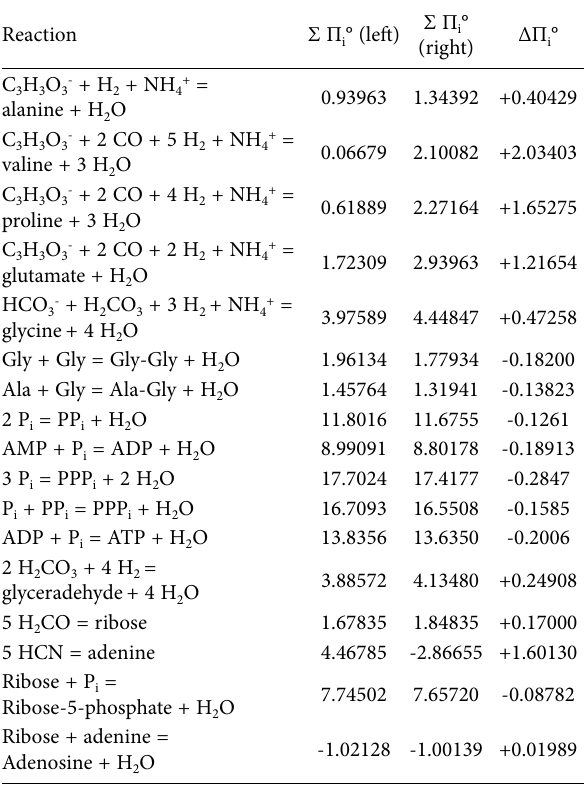
Table 9. Thermodynamic analysis of the abiotic synthesis of the some aminoacid from pyruvate and their condensation into